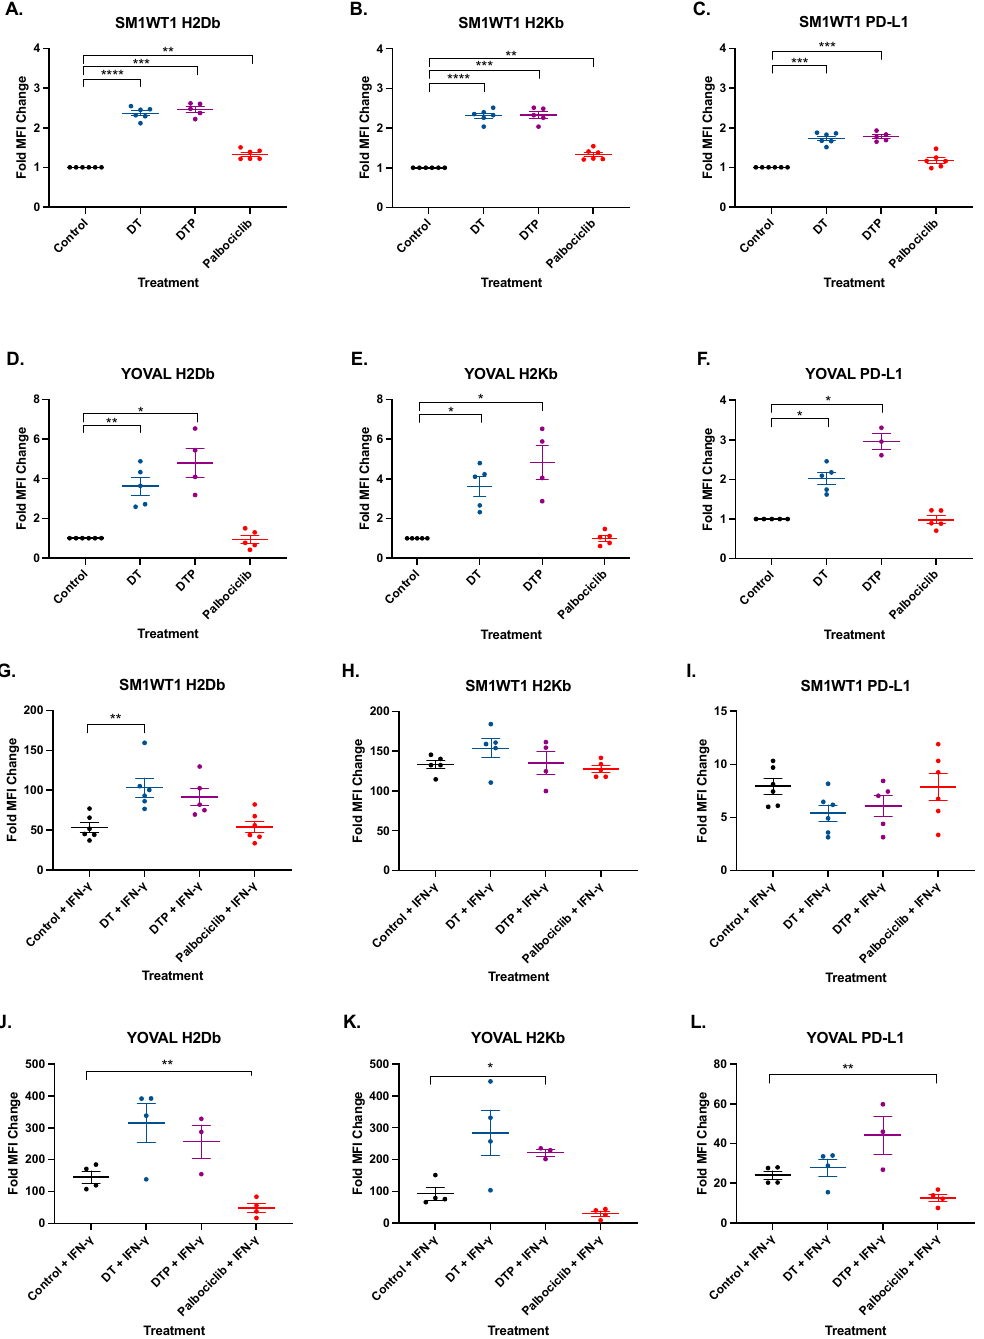
Figure 5. SM1WT1 and YOVAL1.1 MHC Class I and PD-L1 Expression. Samples analyzed using FACS for H2Db ( A , D , G , J ), H2Kb ( B , E , H , K ), and PD-L1 ( C , F , I , L ). SM1WT1 and YOVAL1.1 were treated with dabrafenib-trametinib (DT), dabrafenib-trametinib-palbociclib (DTP), or palbociclib alone. Median fluorescent intensity of the respective treatment group was normalized back to controls and expressed as fold MFI change. Mean ± SEM. n = 3–5. Statistical significance was determined using a one-way ANOVA * p < 0.05, ** p < 0.01, *** p < 0.001, **** p < 0.0001.